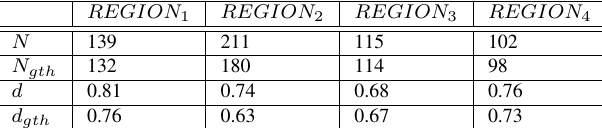
Figure 5: A small part of Stadium 1 test image. Labels of de- tected crowds which are used for performance analysis are writ- ten on the image. Table 1: Comparison of groundtruth and automatically detected people number and density estimation results for test regions in Stadium 1 . N and d stand for number of people and number of people per square meter